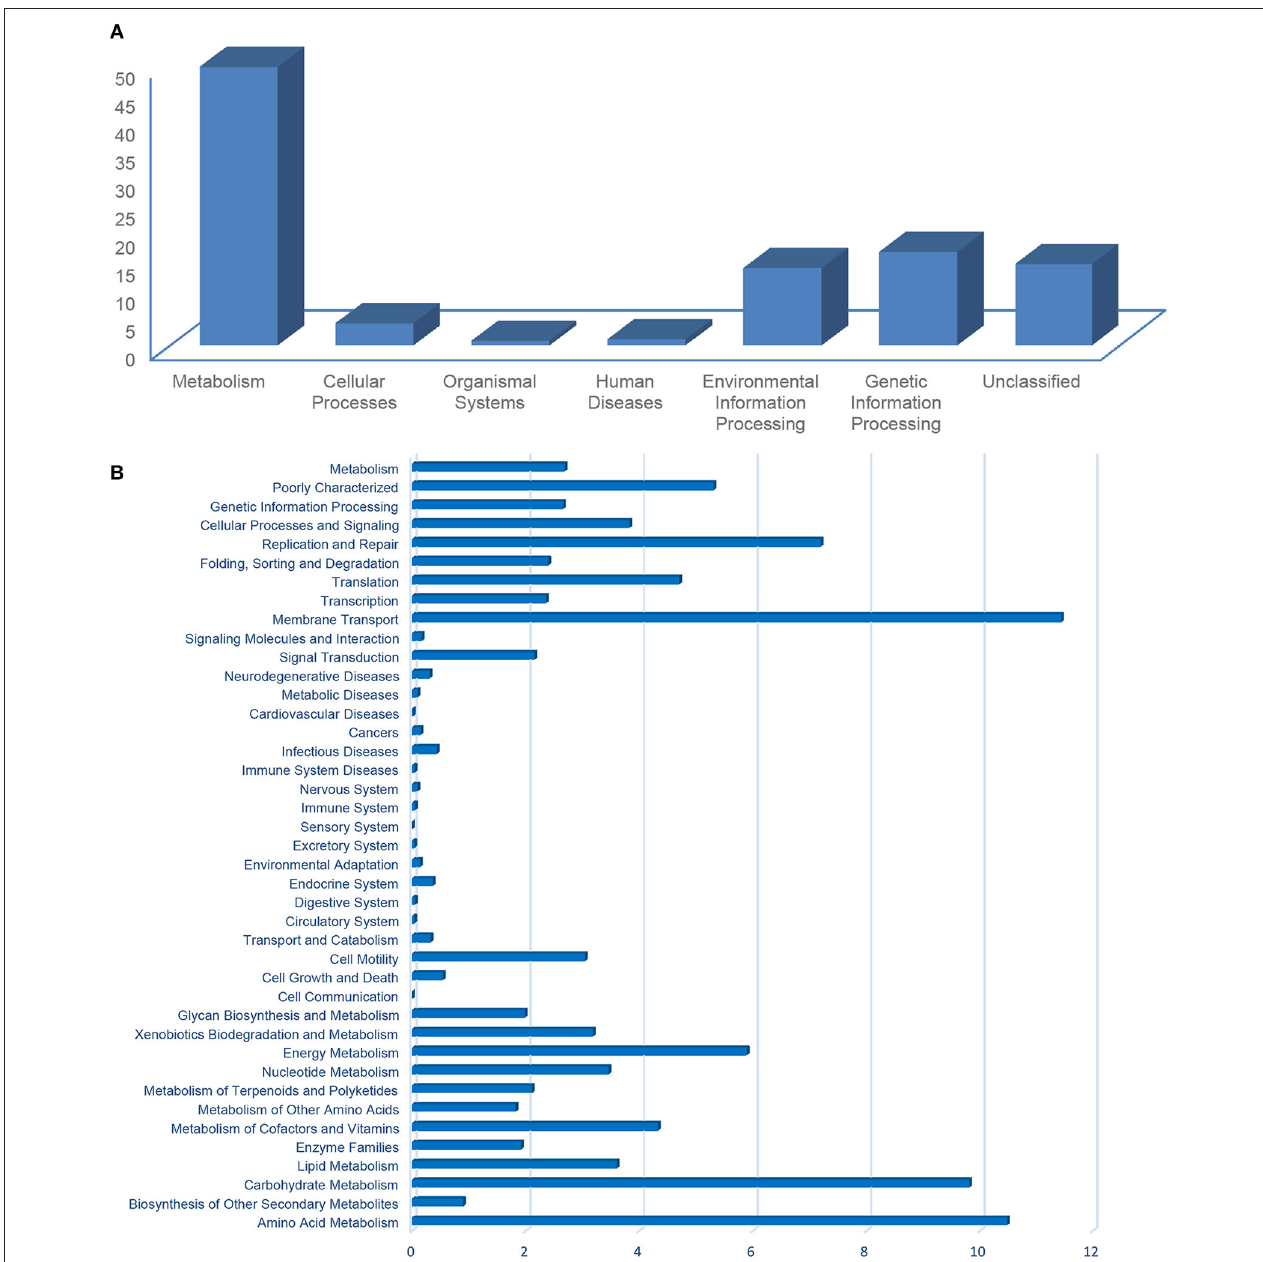
FIGURE 7 | Prokaryote functional prediction into KEGG pathways (A) and categories of genes (B) , using PICRUSt.